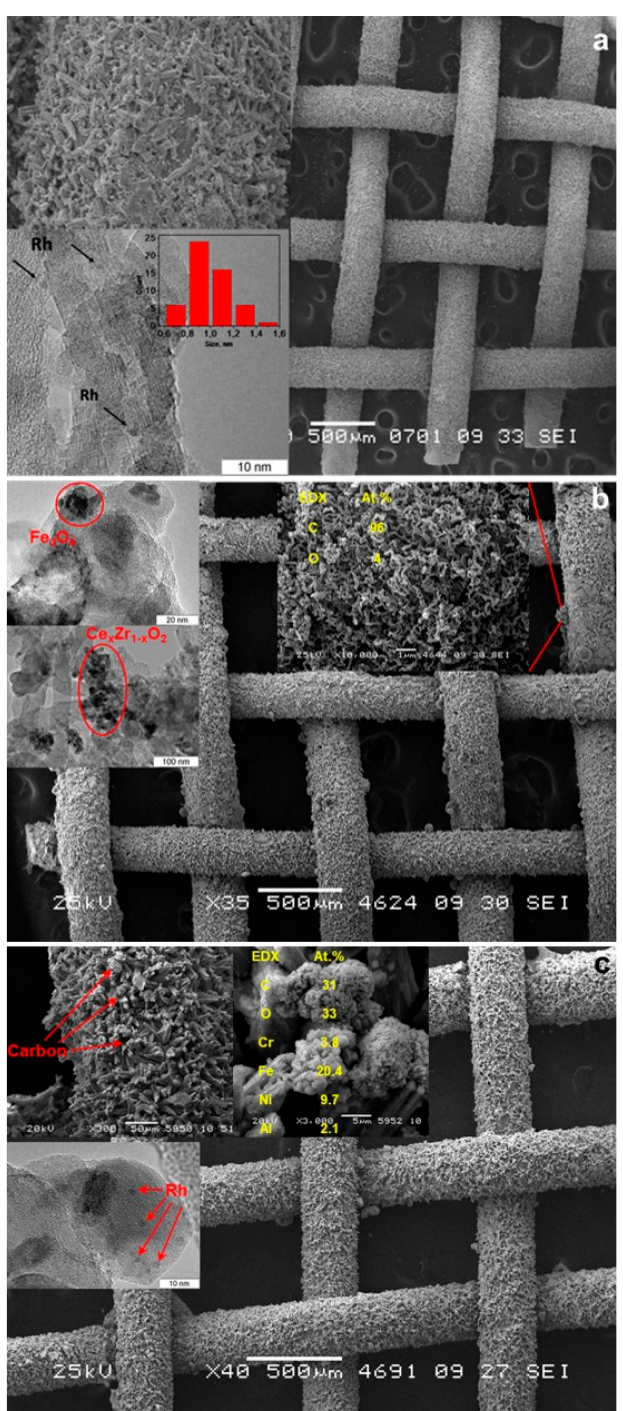
Figure 15. The TEM and SEM images and respective EDX patterns for the as-prepared ( a ) and the used catalytic block (250 h on stream): the frontal part ( b ) and the end part ( c ) [93].